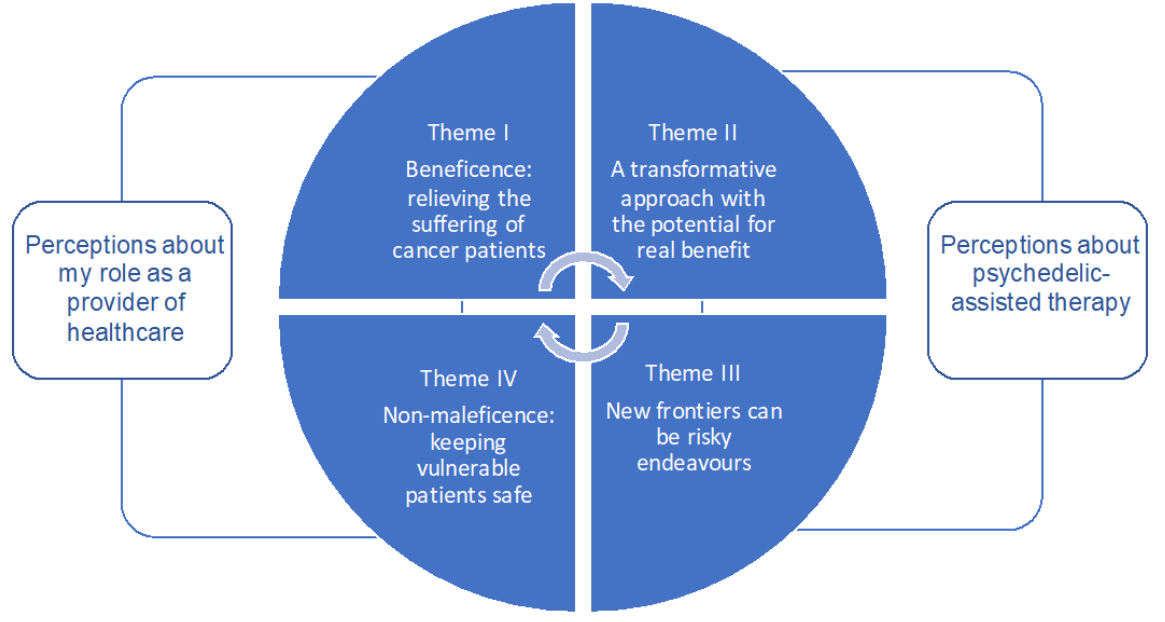
Figure 2. Key themes related to cancer healthcare workers perceptions of psychedelic-assisted therapy.